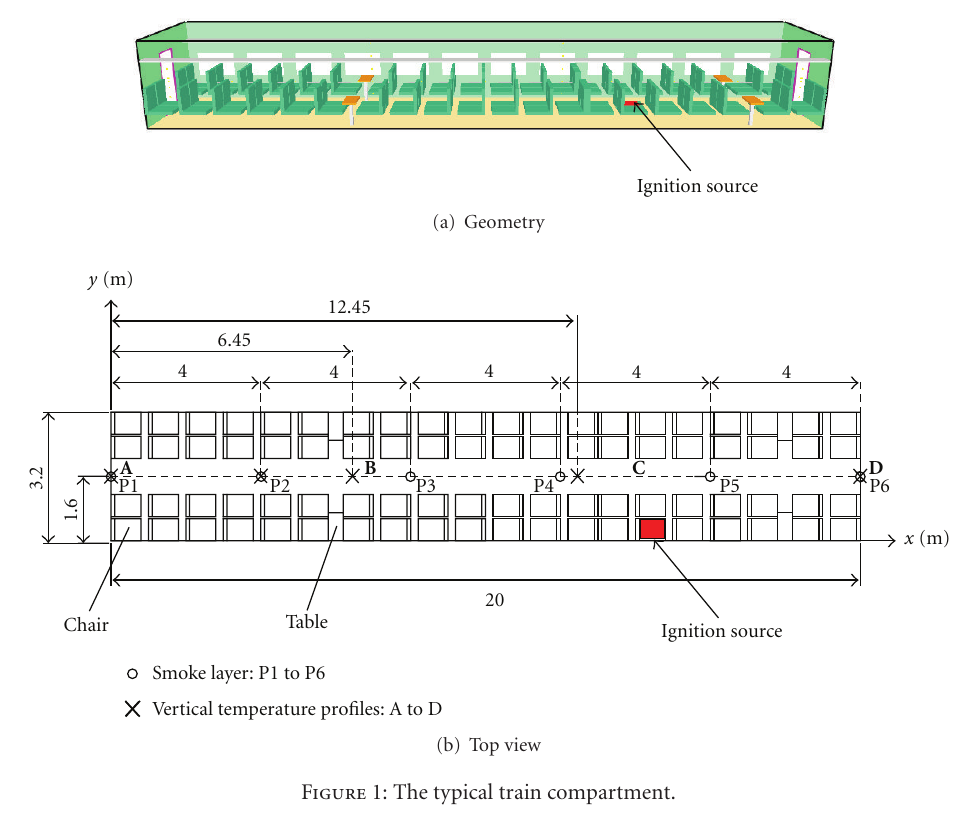
Figure 1: The typical train compartment.